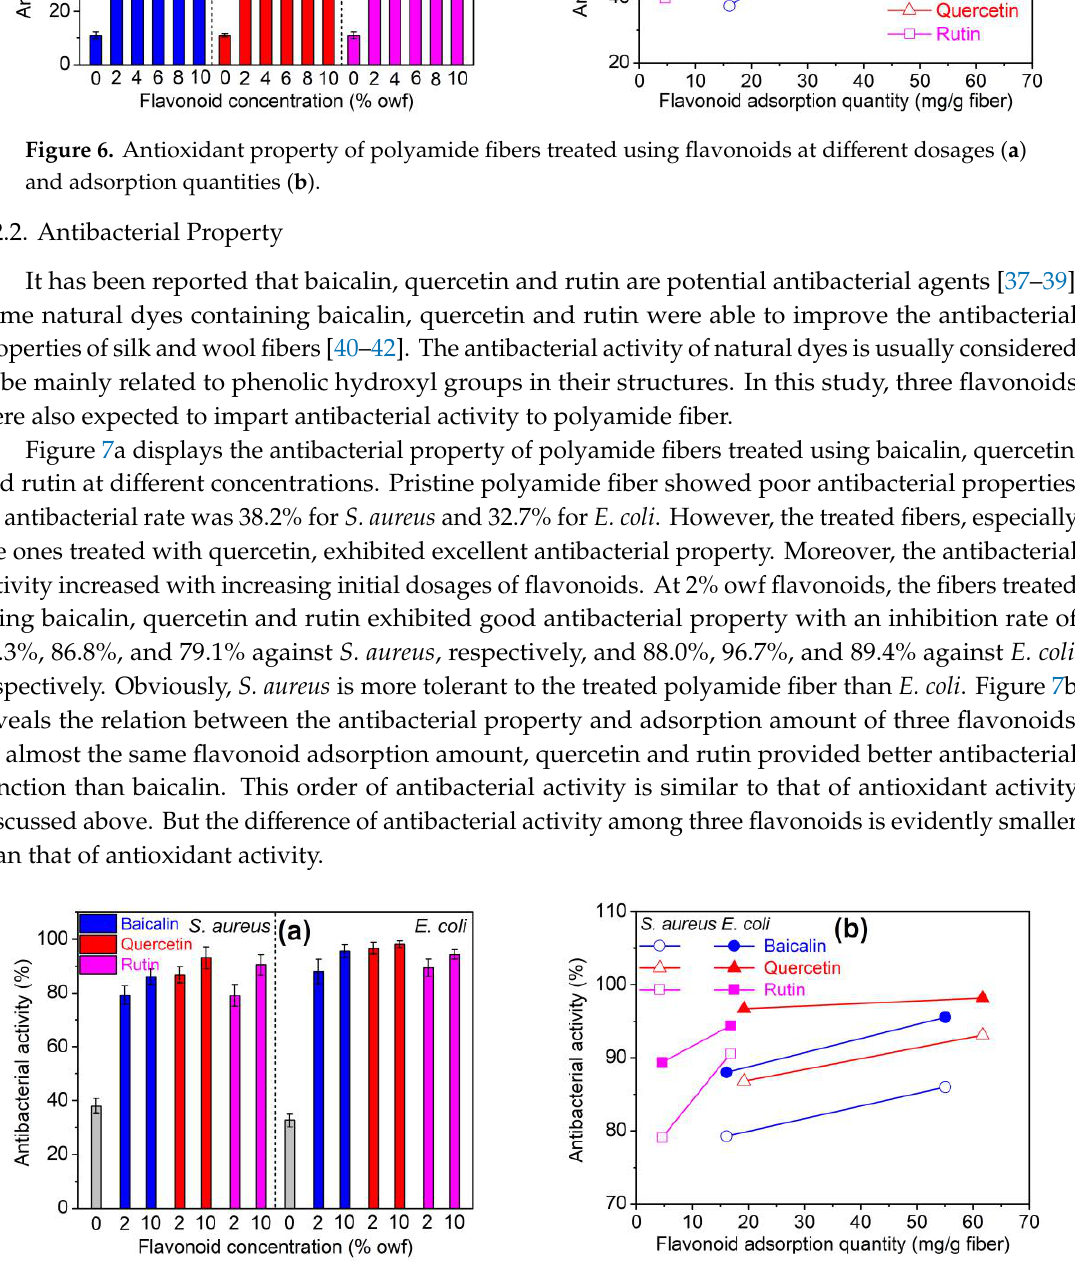
Figure 7. Antibacterial property of polyamide fibers treated using flavonoids at different dosages ( a ) and adsorption quantities ( b ).